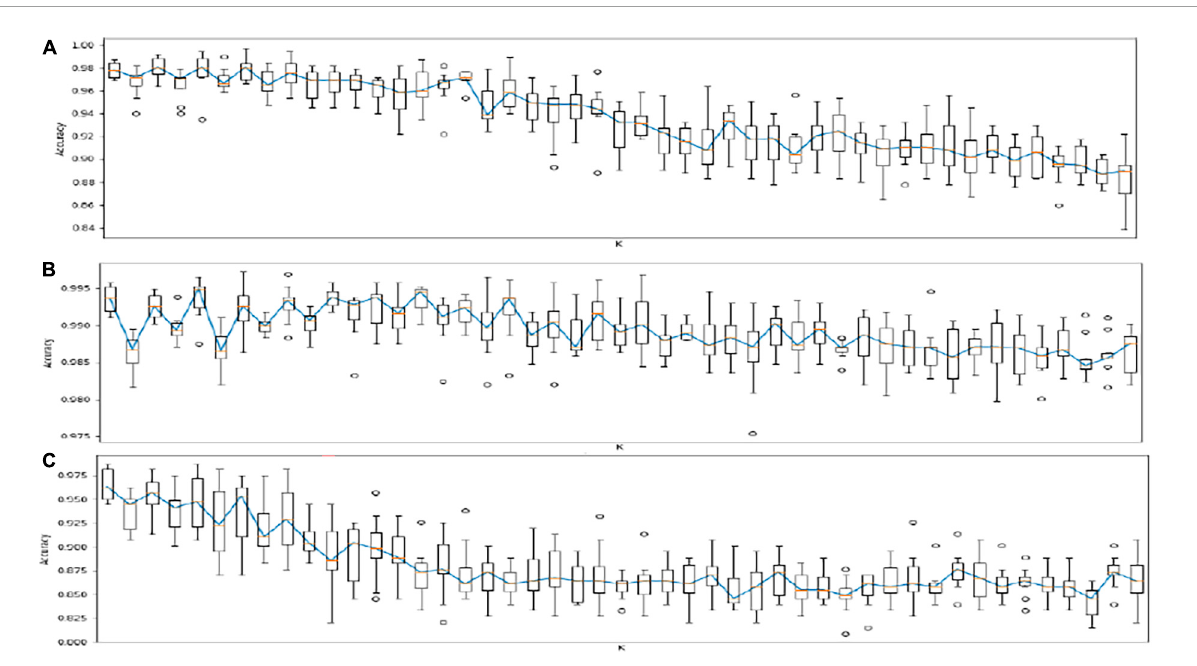
FIGURE3 Results of risk algorithms through kNN analyses. Each algorithm of KNN analysis was tested 10 times in the phase or training (70%) and validation (30%). (A) Risk models for AF in individuals with CAD (ACC: 0.93; AUC: 0.81; Sensitivity: 0.63; and Specificity: 0.99). (B) Risk models for AF in individuals with OSA (ACC: 0.92; AUC: 0.70; Sensitivity: 0.99; and Specificity: 0.40). (C) Risk models for AF in all individuals of the sample (ACC: 0.95; AUC: 0.80; Sensitivity: 0.99; and Specificity: 0.63). AF, Atrial Fibrillation; CAD, Coronary Artery Disease; SA, Sleep Apnea; ACC, Accuracy; AUC, Area Under de ROC: The average value of sensitivity for all possible values of specificity; ROC, Receiver Operating Characteristic (ROC) Curve. A plot of test sensitivity as the y coordinate versus its 1-specificity or false positive rate (FPR) as the x